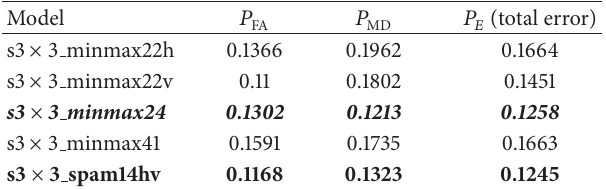
Table 4: Detection results of the EDGE3 × 3 submodels.